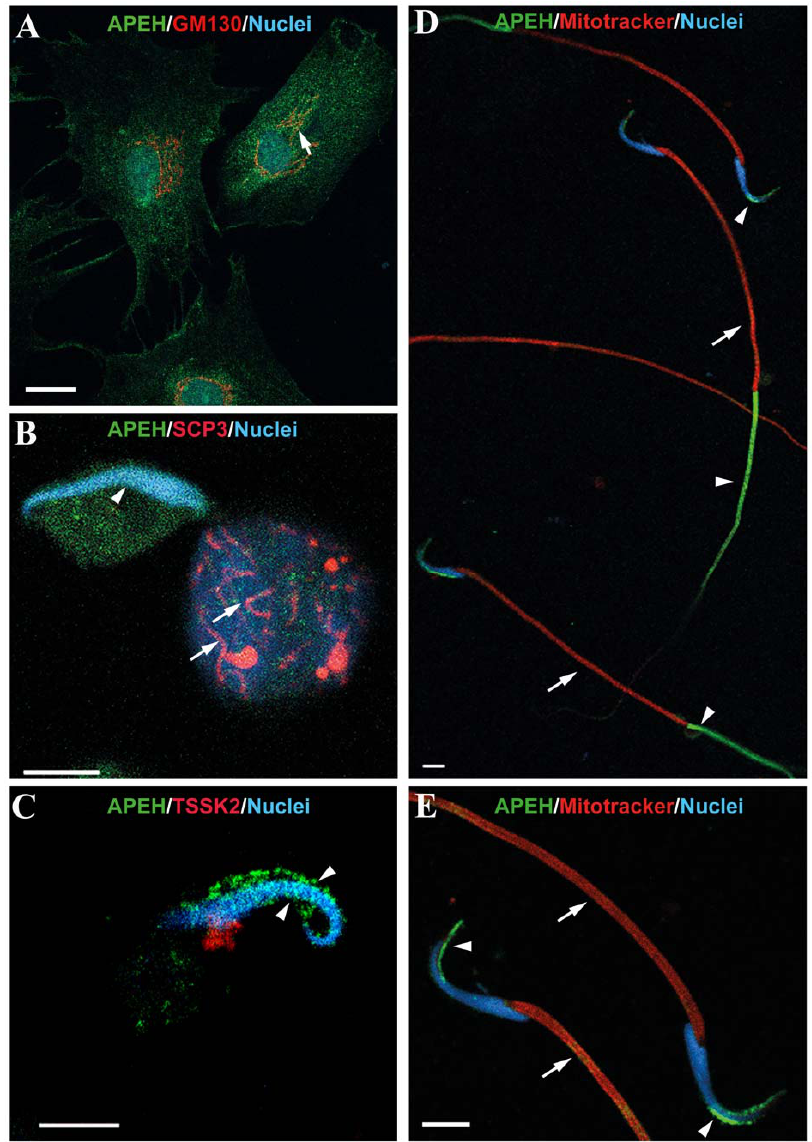
Figure 4. Subcellular distribution of APEH in isolated cells obtained from male rat reproductive tissues. Immunofluorescence against APEH (green) in Sertoli cells ( A ), germ cells ( B ), and spermatozoa ( C ) obtained from primary cultures and epididymal cauda from male rats, respectively. ( A ) a homogeneous cytoplasmic APEH signal is observed in Sertoli cells. The white arrow indicates partial colocalization of APEH with GM130 ( cis- Golgi marker, red). ( B ) In early germ cells, a homogeneous distribution of APEH signal was observed. The white arrows indicate the distribution of SCP3 meiosis-specific marker (Synaptonemal complex protein 3, red) and white arrowheads show the nucleus of a round spermatid. ( C ) APEH signal in elongated spermatids. The white arrowheads show the differential distribution of APEH surrounding the nucleus of the elongated spermatid. ( D ) The APEH signal is distributed surrounding the upper part of the nucleus and in the principal piece of the sperm tail (white arrowheads). MITOTRACKER RED was used to identify the midpiece (white arrows). ( E ) Zoom of the sperm heads shown in 4D. APEH signal is distributed around the nucleus (white arrowheads) and MITOTRACKER RED in the midpiece (white arrows). Nuclei were stained with Hoechst (blue). Scale bar = 20 µm.